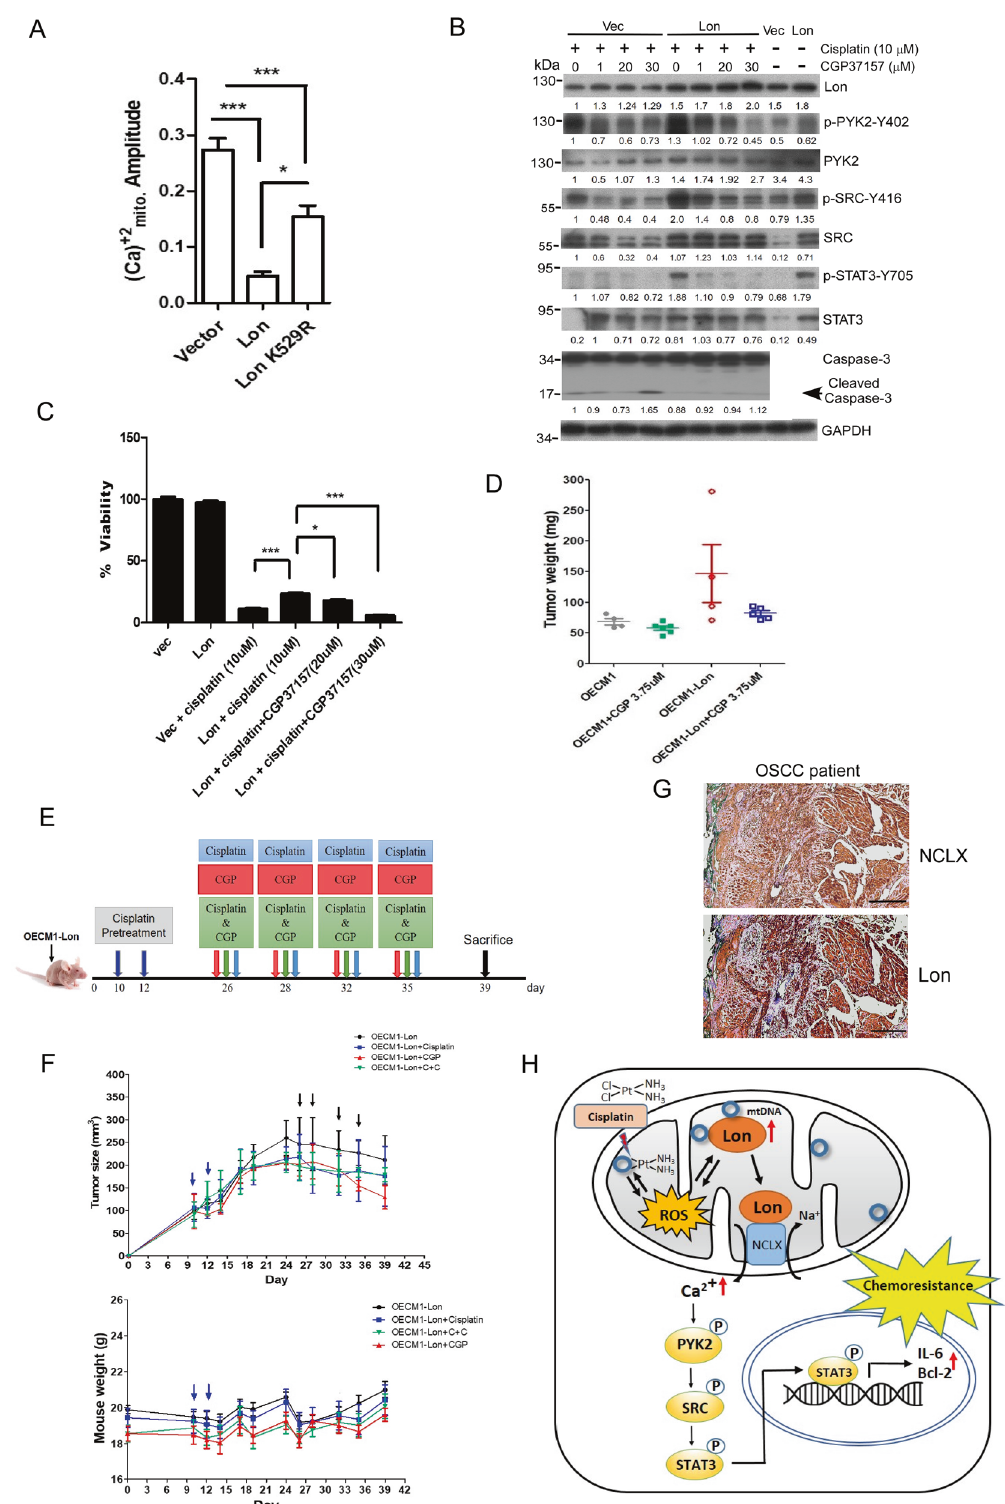
cisplatin and Lon downregulation sensitizes cells towards cisplatin. Intriguingly, mitochondrial Lon contributes to cisplatin resistance through the interaction with NCLX, which induces an increase in cytosolic calcium level leading to inhibition of apoptosis (Fig. 7H). This study signi fi es that cisplatin-induced